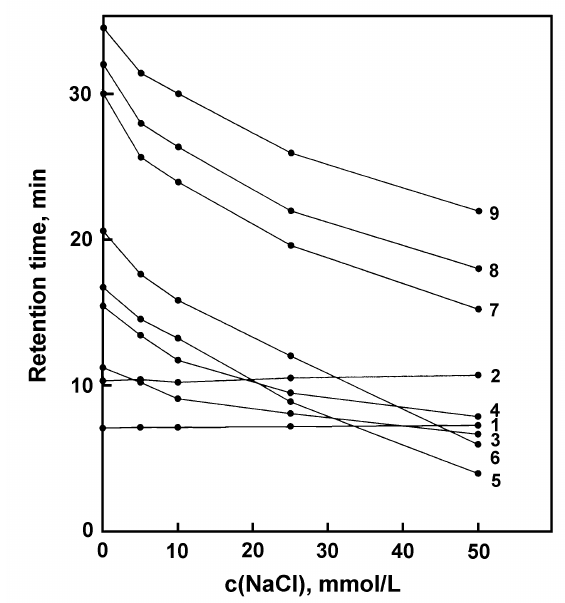
Fig. 2 Effect of NaCl concentration on retention times. Mobile phase: 7.5